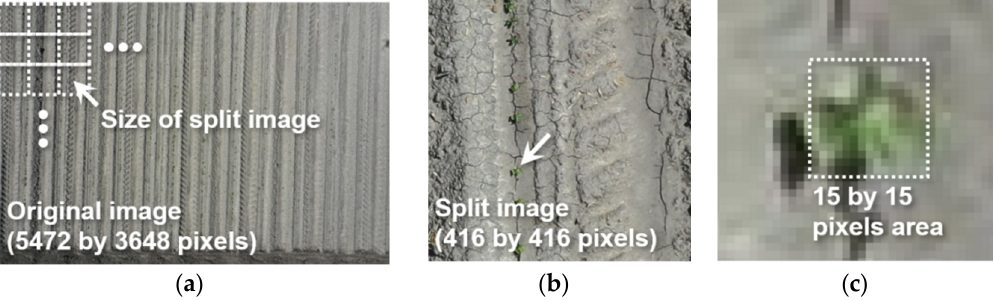
Figure 5. Example of ( a ) raw UAS image collected on 15 April 2019 and ( b ) split image used for object detection, where ( c ) cotton seedling appears approximately in 15 by 15 pixels.